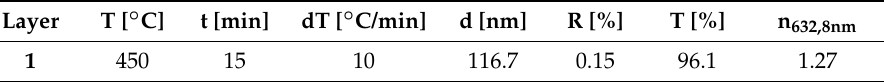
Figure 9. Reflectance and transmission curves of KMgF 3 thin film. Table 6. Overview of layer properties.